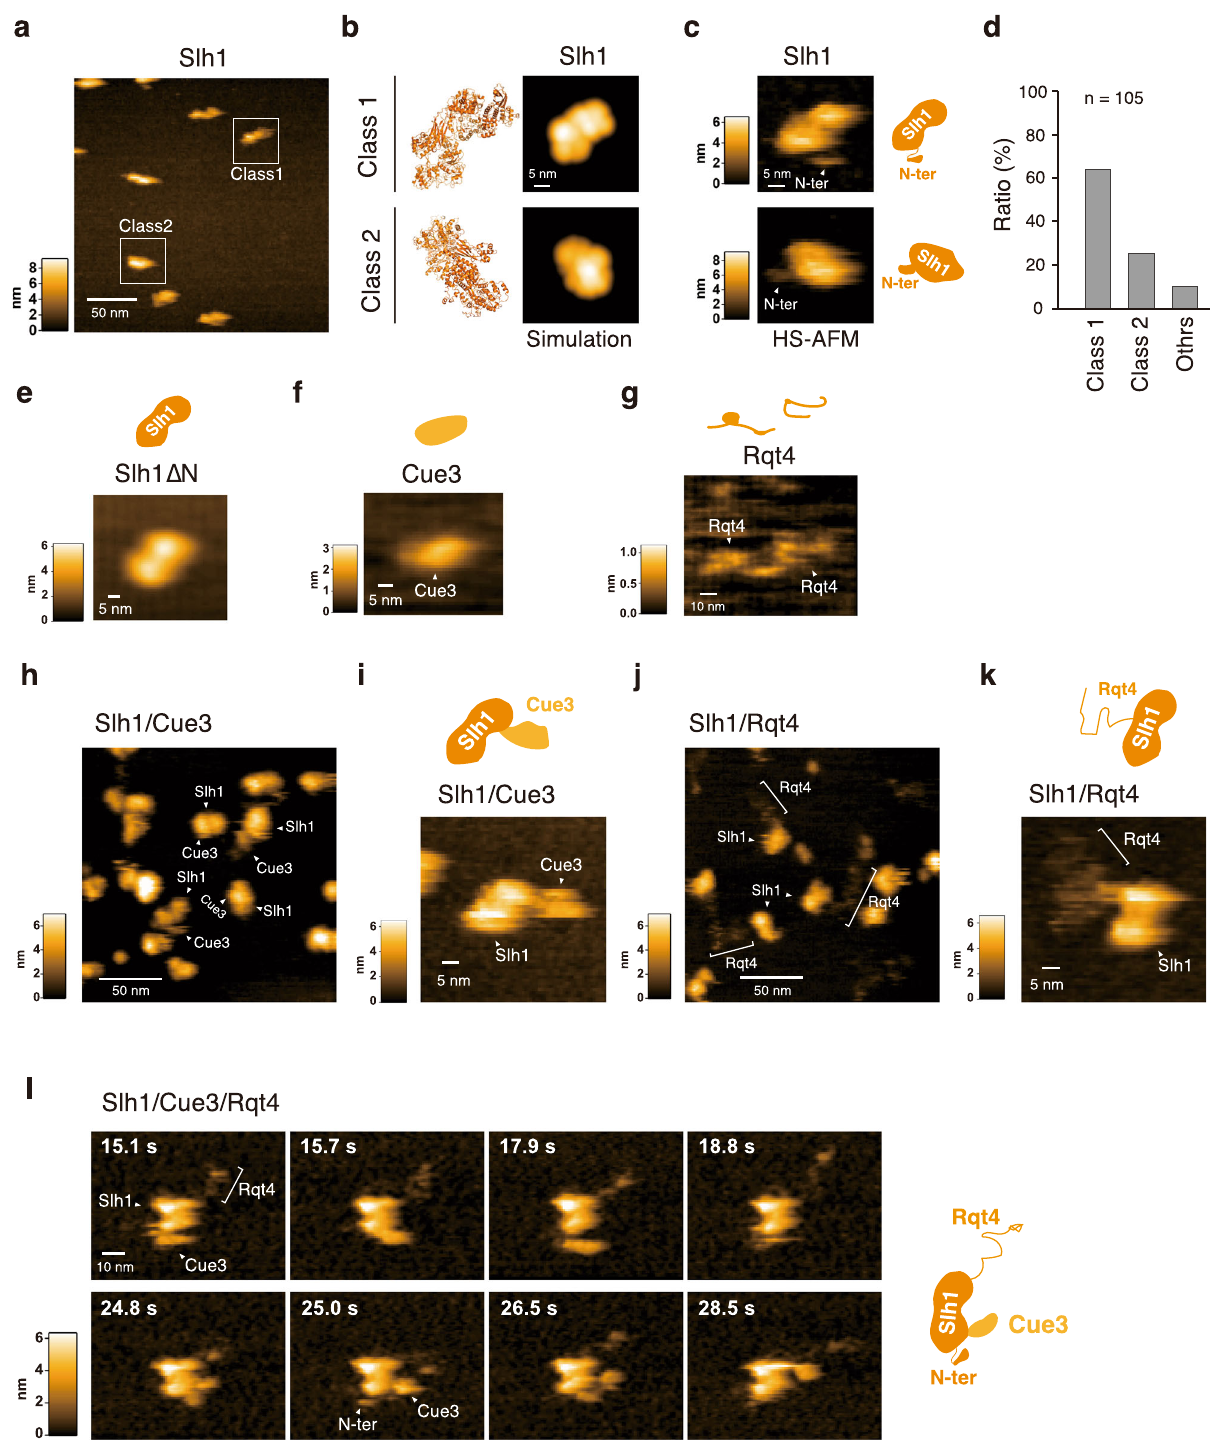
Fig. 3 | The dynamics of the RQT complex. a HS-AFM image of Slh1. Two major particles were indicated as Class1 and Class2. b The pseudo-AFM images of Slh1 belonging to Class1 and Class2 particles, which were simulated using predicted Slh1 structure lacking N-terminal region by Alphafold2. c The HS-AFM images and schematized molecular features of Slh1. d Classi fi cation of Slh1 particles. All particles